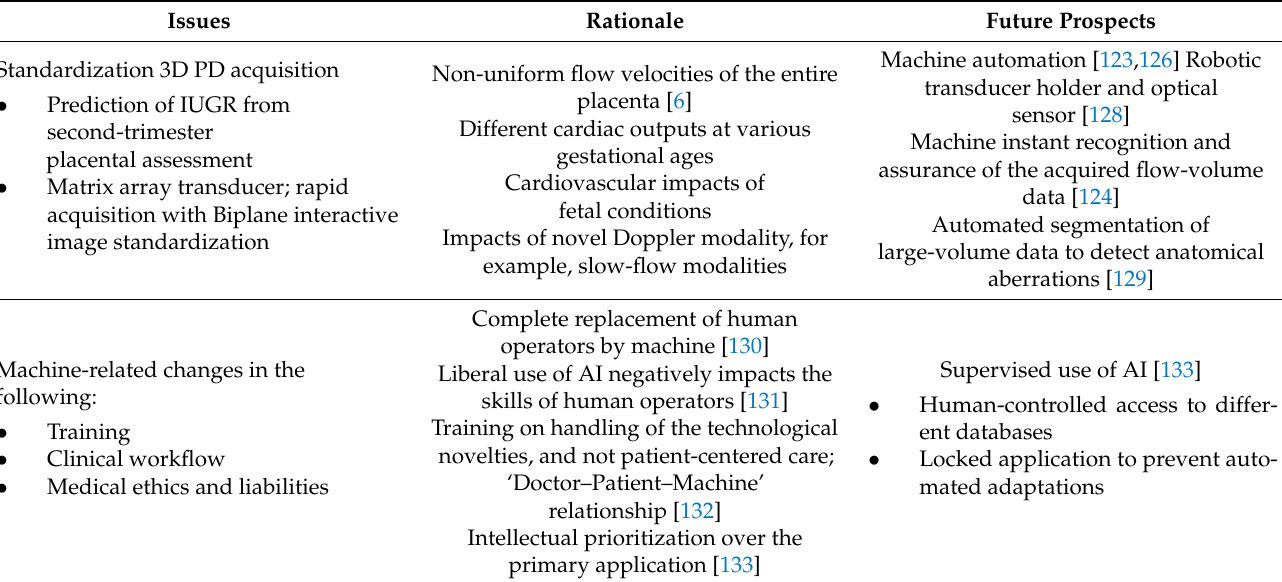
Table 2. Theoretical conjectures of three-dimensional sonoangiography for prenatal assessment. Abbreviations: 3D PD, three-dimensional power Doppler; AI; artificial intelligence; IUGR, intrauterine growth restriction.